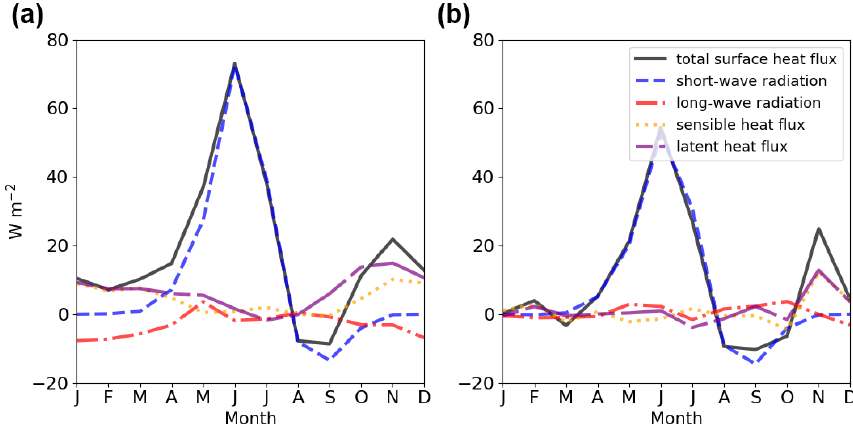
Figure 5. Anomalies (LIG–PI) of the components of the surface energy budget from (a) the LIG simulation (adapted from Guarino et al., 2020b) and (b) the first year of LIG spin-up. For the LIG, PI, and the first year of the LIG spin-up period, the spatial average was computed from monthly data over the region from 70–90 ◦ N for the simulated short-wave radiation, long-wave radiation, sensible heat flux, and latent heat flux. For the LIG and PI periods, the 200-year mean was used. The total surface heat flux anomaly (black) is the sum of these four heat budget